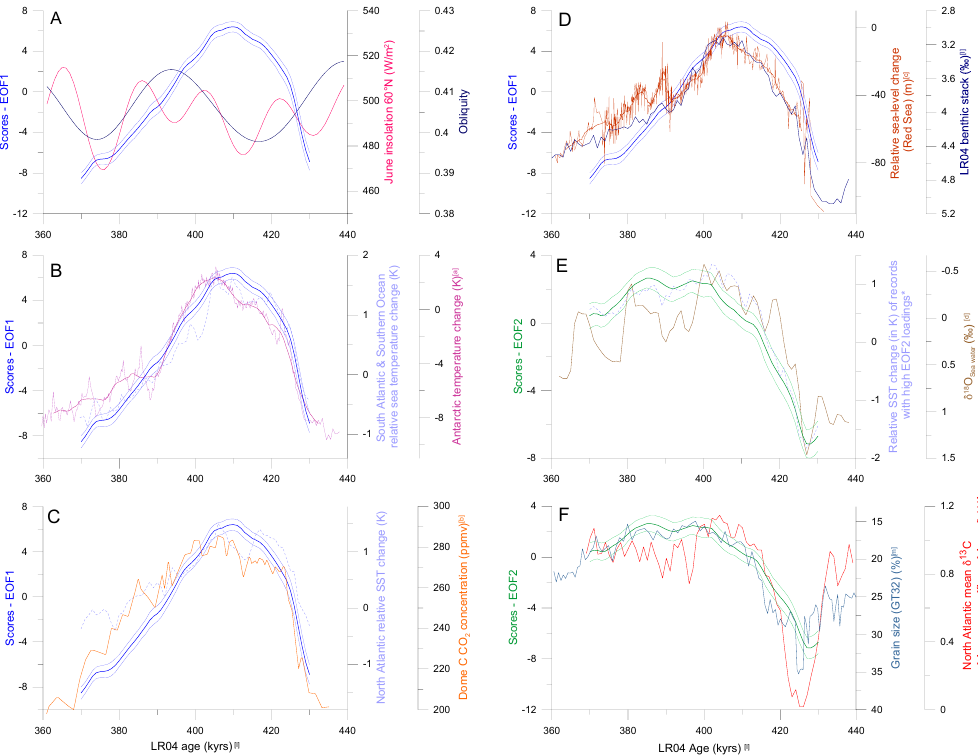
Fig. 8. Scores of the first EOF with their confidence intervals versus (A) orbital parameter (June insolation at 60 ◦ N and obliquity (Laskar et al., 2004)), (B) relative temperature changes in the South Atlantic and Southern Ocean and Antarctic temperature changes recorded in the Dome C ice core during MIS11 (Jouzel et al., 2007; [a]) (thin pink line: original data; thick pink line: smoothed curve), (C) mean relative temperature change in the North Atlantic records with high loadings to the first EOF and CO 2 concentration recorded in the Dome C ice core from the Antarctic (Siegenthaler et al., 2005; [b]), and (D) relative sea-level changes in the Red Sea (Rohling et al., 2009; [c]) and the LR04 benthic stack (Lisiecki and Raymo, 2005; [l]). Scores of the second EOF mean relative temperature changes in records with high positive loadings ( > 0.75) on the second EOF versus (E) δ 18 O of sea water as proxy for ice volume (Elderfield et al., 2012; [d]), and (F) mean δ 13 C values in the North Atlantic as a proxy for North Atlantic deep water (NADW) strength and the East Asian winter monsoon signal as reflected by the GT32 grain size (content of > 32µm particles) in loess sequences (Hao et al. 2012; [m]; note inverse scale). For the mean of δ 13 C North Atlantic, records between 1100 and 2300m water depth were selected according to Lisiecki et al. (2008). The δ 13 C records used here are from Shackleton and Hall (1984) [e], Oppo et al. (1998) [f], Venz et al. (1999) [g], Raymo et al. (1998) [h], McIntyre et al. (1999) [i], Kleiven et al. (2003) [j], and Raymo et al. (2004) [k]. The EDC ages of the records from the Dome C ice core in (B) and (C) were converted into LR04 ages (Lisiecki and Raymo, 2005; [l]) according to Parrenin et al. (2007). (*) Records with high EOF2 loadings are from IODP Site U1313 & ODP Site 958 (North Atlantic), ODP Site 975 & ODP Site 976 (Mediterranean Sea) and ODP Site 1168 (south of Australia).